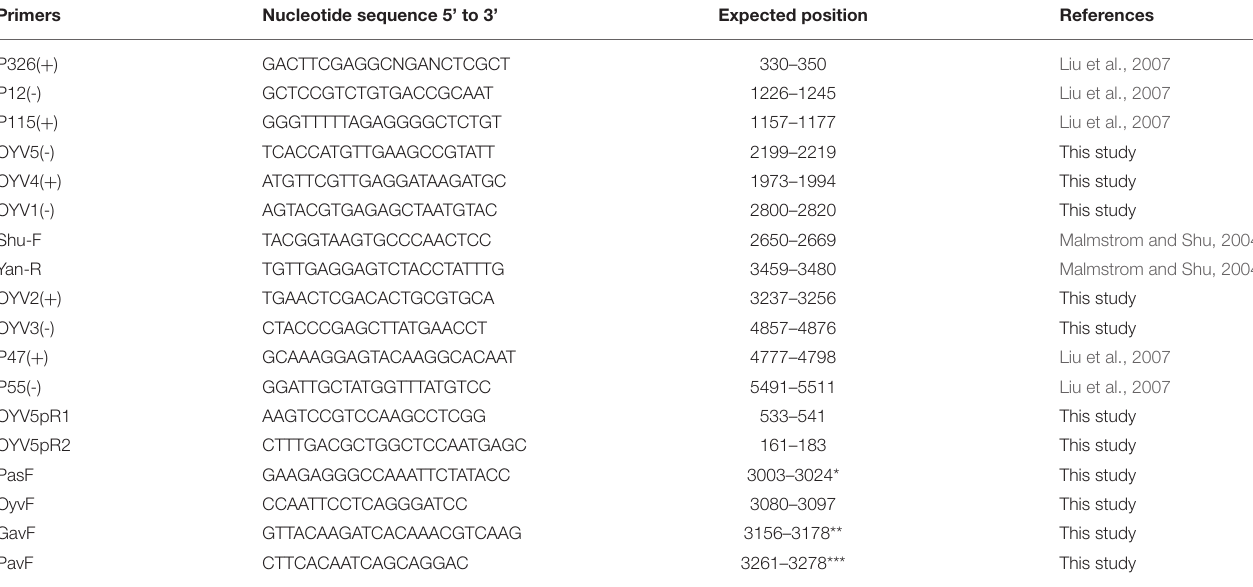
TABLE 1 | Primers used in the current